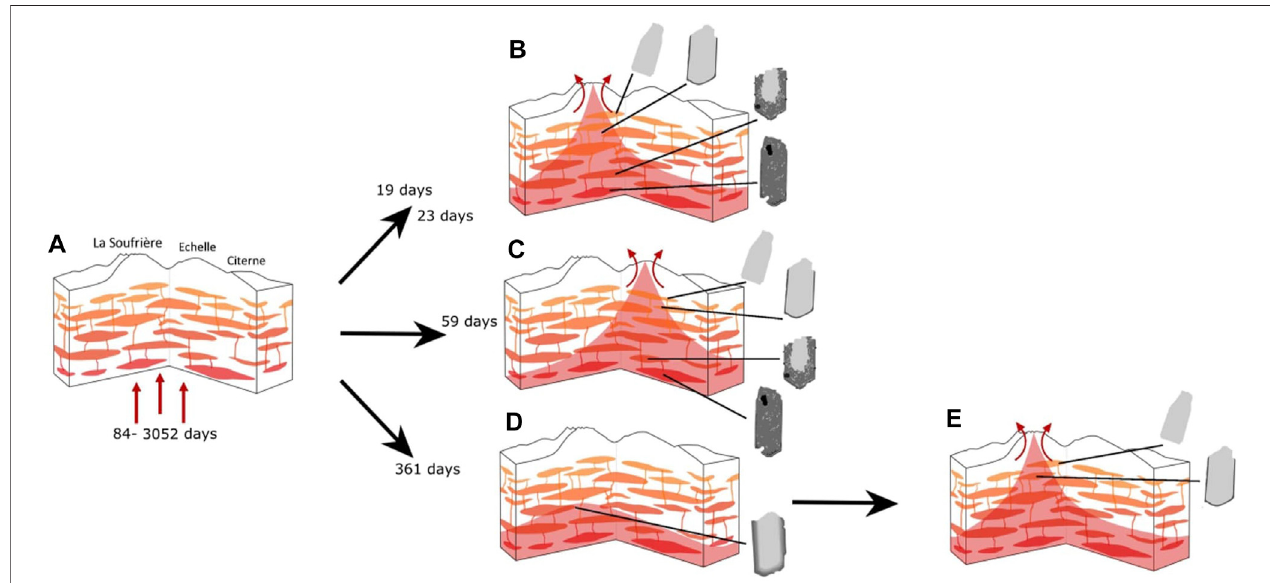
FIGURE 11 | Schematic sketches of the mush lenses beneath La Soufrière de Guadeloupe and Echelle with representative crystals shown at approximate locationswithinthemushzone. (A) TheLaSoufrièredeGuadeloupemushsystempriortoeruption,thisstudysuggestsintrusionsbeginabetweenaminimumof84and 3,052 dayspriortoeruption. (B) Inthecaseof1657Cal.CEand5680Cal.BCEeruptions,theexpectedvalueshowsthatthemajorityofthesystemcouldbeaffectedby an intrusion 19 and 23 days prior to eruption, respectively. The intrusion moves through the system rapidly, in the case of the 5680 Cal. BCE eruption crystals are erupted from deep in the mush system which re-equilibrate during smaller intrusion events which do not destabilise the mush system. The 1657 Cal. CE eruption only samplessimplecrystalsandunzonedcrystals. (C) The ∼ 341CEeruptionexpectedvalueshowsthatthemajorityofthesystemcouldbeaffectedbyanintrusion59 days before eruption. This intrusion has also moved relatively rapidly through the system and variation in intrusion location, results in destabilisation and eruption from the Echelle vent. Both complex and simple crystal populations are erupted. (D) Processes resulting in the 1010 Cal. CE eruption occurred slower than the other eruptions with the expected value showing the majority of the system could be affected by an intrusion 361 days prior to eruption. The very long delay time suggests that magma may have stalled in the mid-upper mush system, crystals with the diffuse zoning have spent the longest time in contact with the intrusion. (E) System destabilisation results in eruption of populations of simply zoned and unzoned crystals, perhaps from the upper